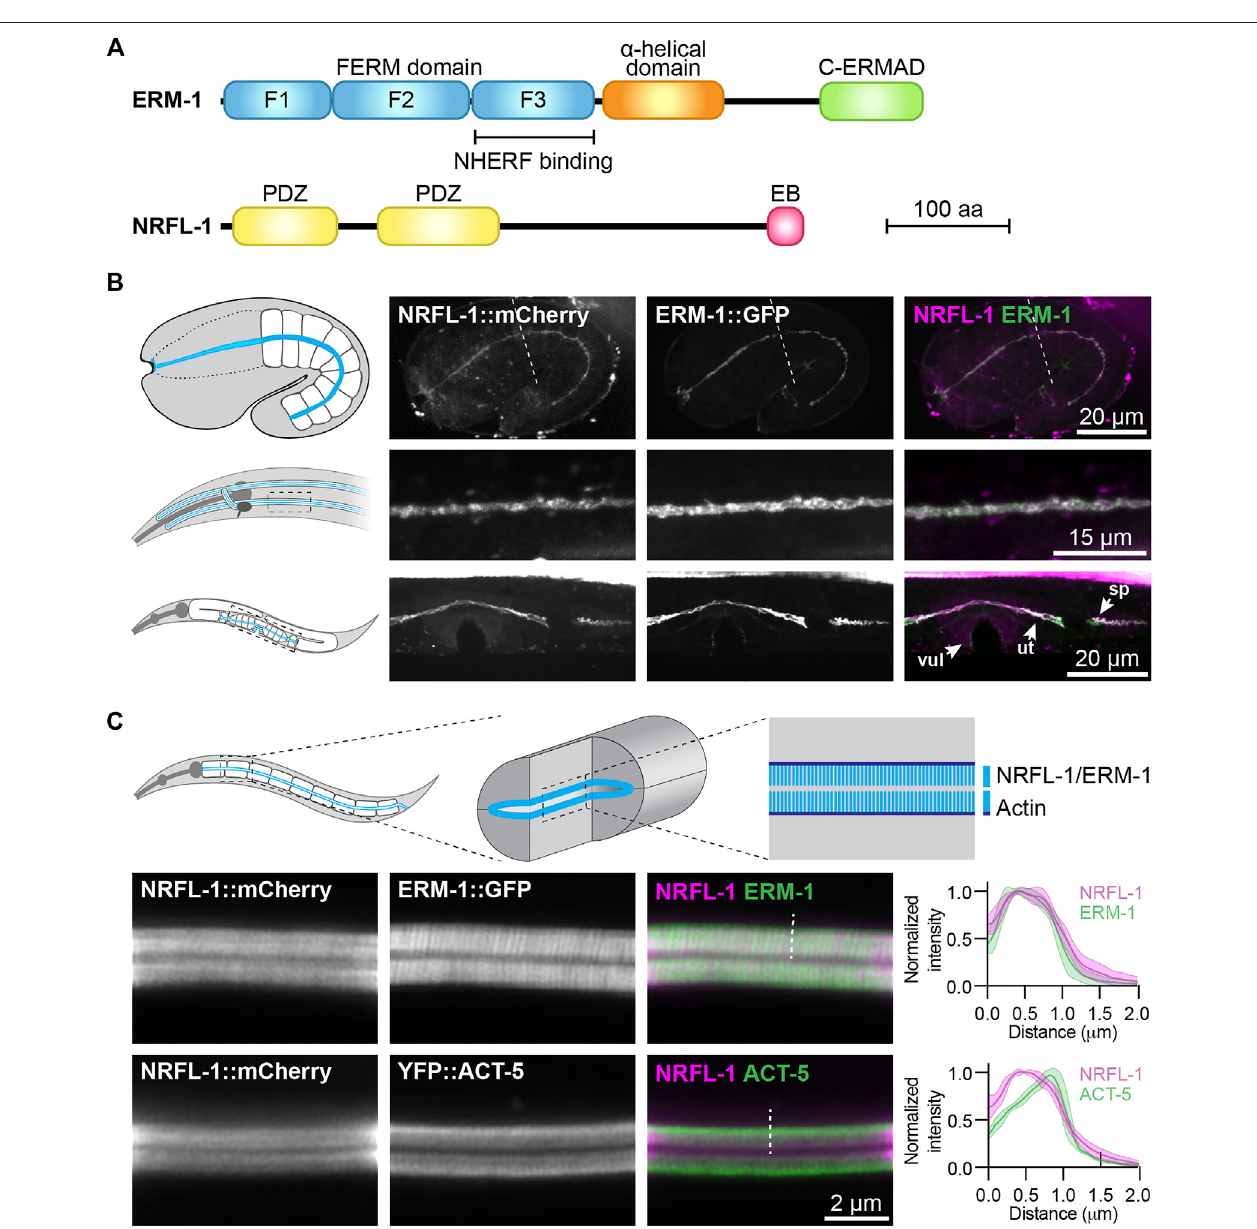
FIGURE1| NRFL-1::mCherrylocalizestotheapicalmicrovilliofintestinalcells. (A) SchematicrepresentationofthedomainorganizationofERM-1andNRFL-1.F1- F3 correspond to the three structural modules making up the FERM domain. FERM (cid:1) Four-point-one, ezrin, radixin, moesin; C-ERMAD (cid:1) C-terminal ezrin Radixin moesin (ERM) association domain; PDZ (cid:1) Post-synaptic density-95, disks-large and zonula occludens-1; EB (cid:1) ERM binding. (B) Distribution of NRFL-1::mCherry and ERM-1::GFP in embryos (top panels), the excretory canal in L1 larvae (middle panels), and the vulva (vul), uterus (ut) and spermatheca (sp) in L4 larvae (bottom panels). Dashed line in the embryo panels separates the pharynx (left) from the intestine (right). (C) Distribution of NRFL-1::mCherry relative to ERM-1::GFP and YFP:: ACT-5 at theapicalmembrane ofL4 larvalintestines.Dashed lineserves asan example oftheline scanposition used for thegraphson the right. Graphs plotthe relative fl uorescence intensity from the intestinal lumen to the cytoplasm. Solid line represents the mean and the shading lines the ± SD. n (cid:1) 6 animals for both graphs. Images weretakenusing spinning-disk. (B) and Airyscan confocalmicroscopes (C) , and maximum intensity projections (B) or asingle plane (C) arepresented.Note thatdue to the longer wavelength emitted by mCherry compared to GFP, the microvilli are better resolved using ERM-1::GFP than using NRFL-1::mCherry.